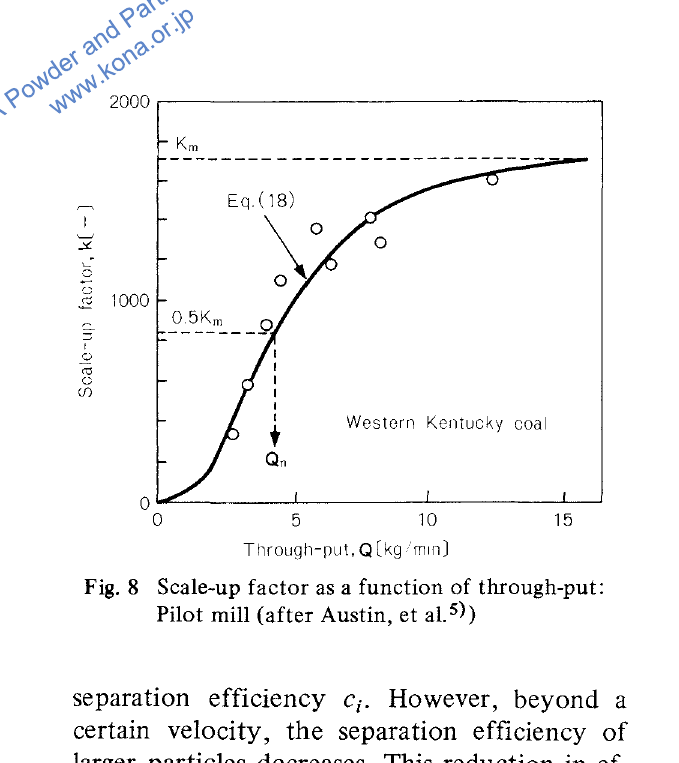
Fig. 8 Scale-up factor as a function of through-put: Pilot mill (after Austin, et al.